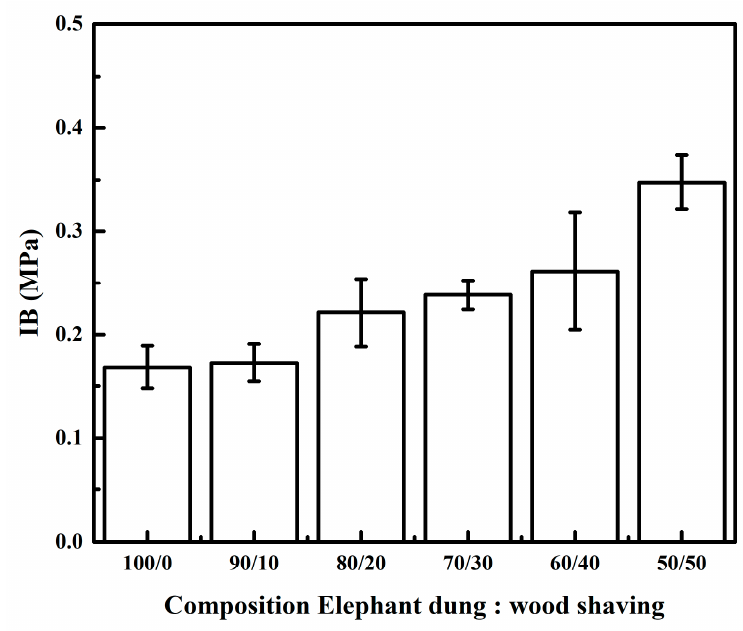
Figure 6. Effect of wood shaving on the IB of elephant dung particleboard.